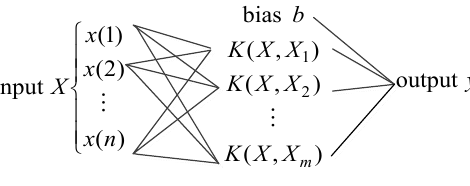
Figure 7. SVM Figure 7. SVM architecture.